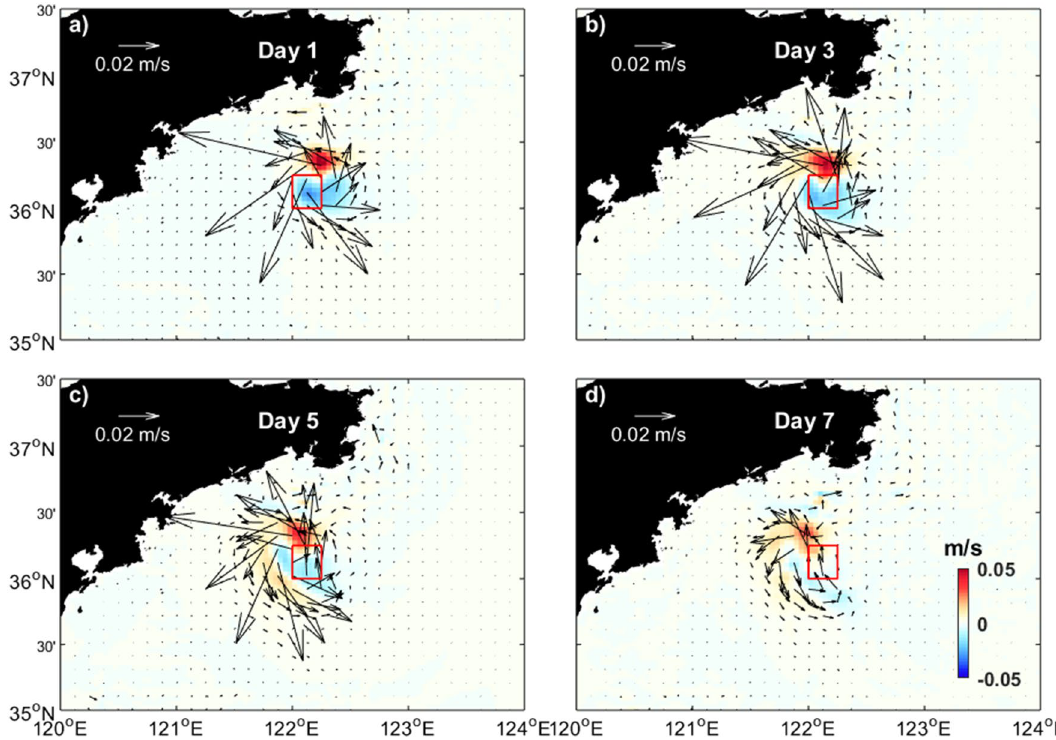
Figure 5. Difference in the daily averaged currents field at the depth of 10 m between an EXP_replace_sen case and EXP0 at days 1, 3, 5, and 7, respectively. The red box indicates the location of the target region. Figures are plotted using MATLAB R2017a (http:// www. mathw orks. com/) with M_Map v1.4 (a mapping package, http:// www. eos. ubc. ca/ ~rich/ map.